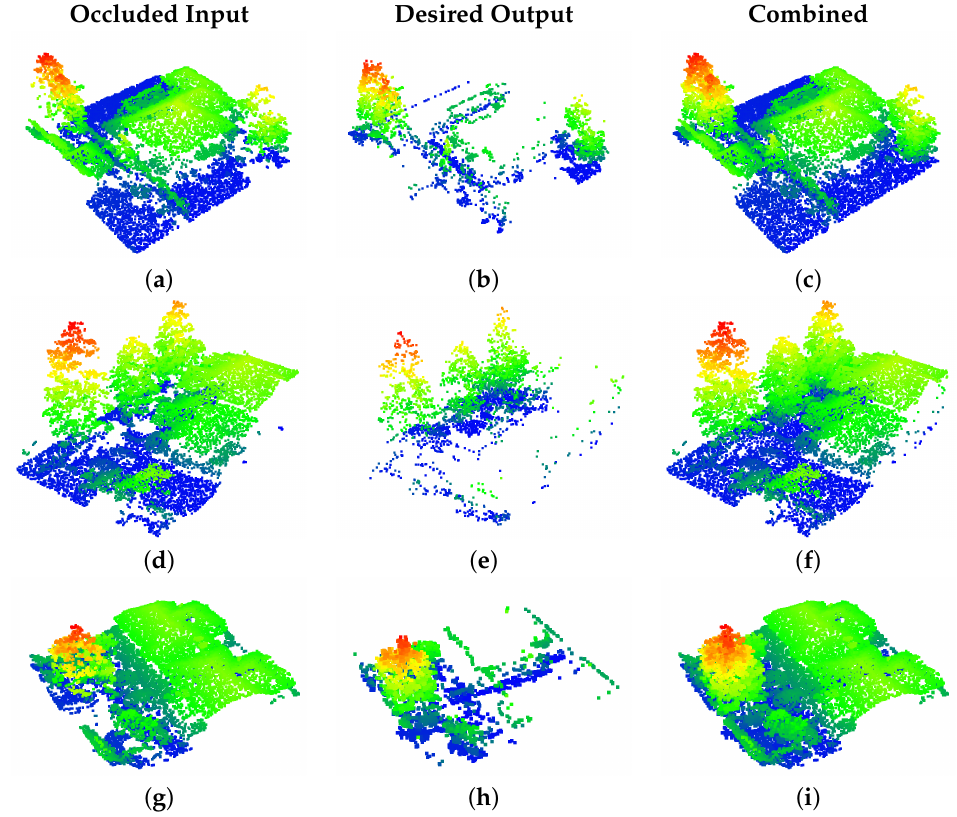
Figure 3. Examples of corresponding scenes from the DALES Viewpoints 2 data set, colored by height. The occluded input is in the left-hand column, the desired output is in the middle, and the combined full point cloud is on the